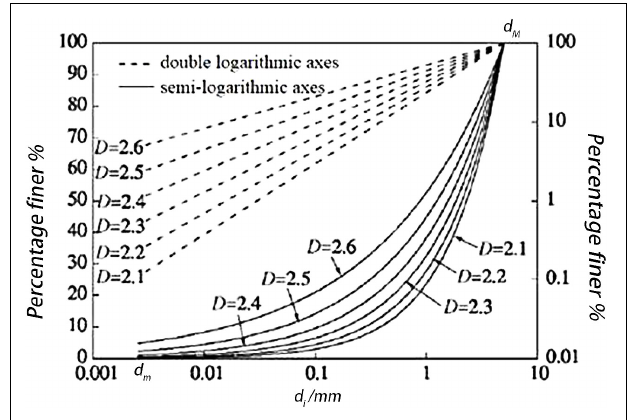
FIGURE 3 | PSD fractal curve.